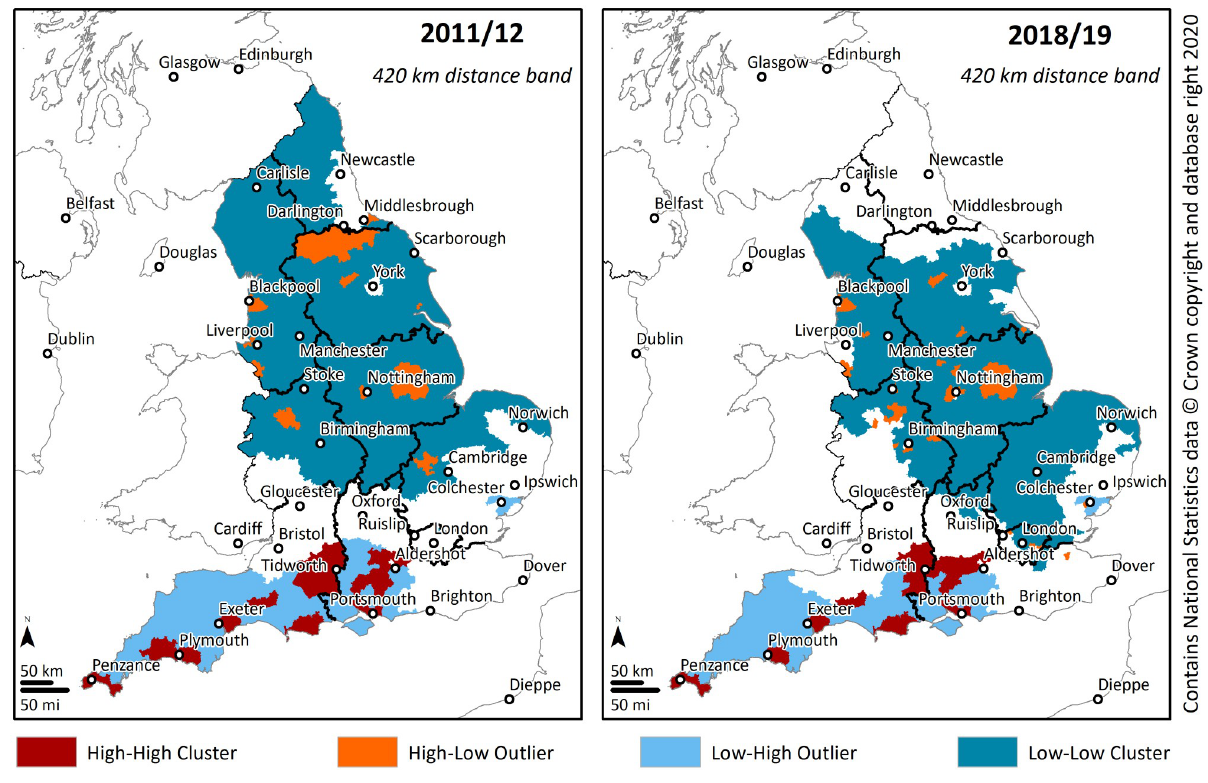
Fig 4. Clusters and outliers of the density of SCPP pupils (420 km distance